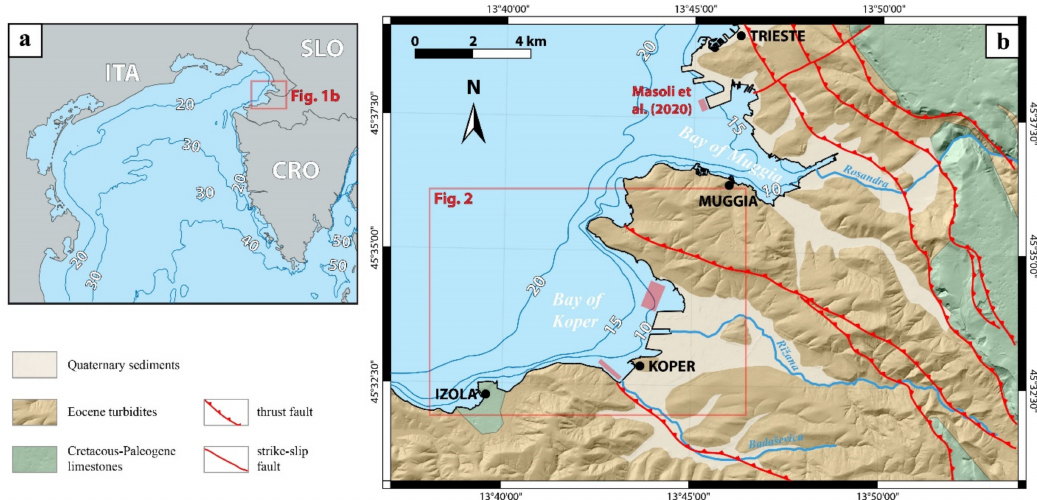
Figure 1. Geographical location of the study area. ( a ) Regional map of the northern Adriatic, which was entirely subaerially exposed during the Last Glacial Maximum (LGM). Bathymetry data from [75]. ( b ) Geological map of the hinterland of the Bay of Koper. Two red rectangles in the Bay of Koper mark the areas investigated in this study. The red rectangle in the Bay of Muggia marks the study area of [76]. Bathymetric data are simplified after [77] and [78]. Geological data are simplified after